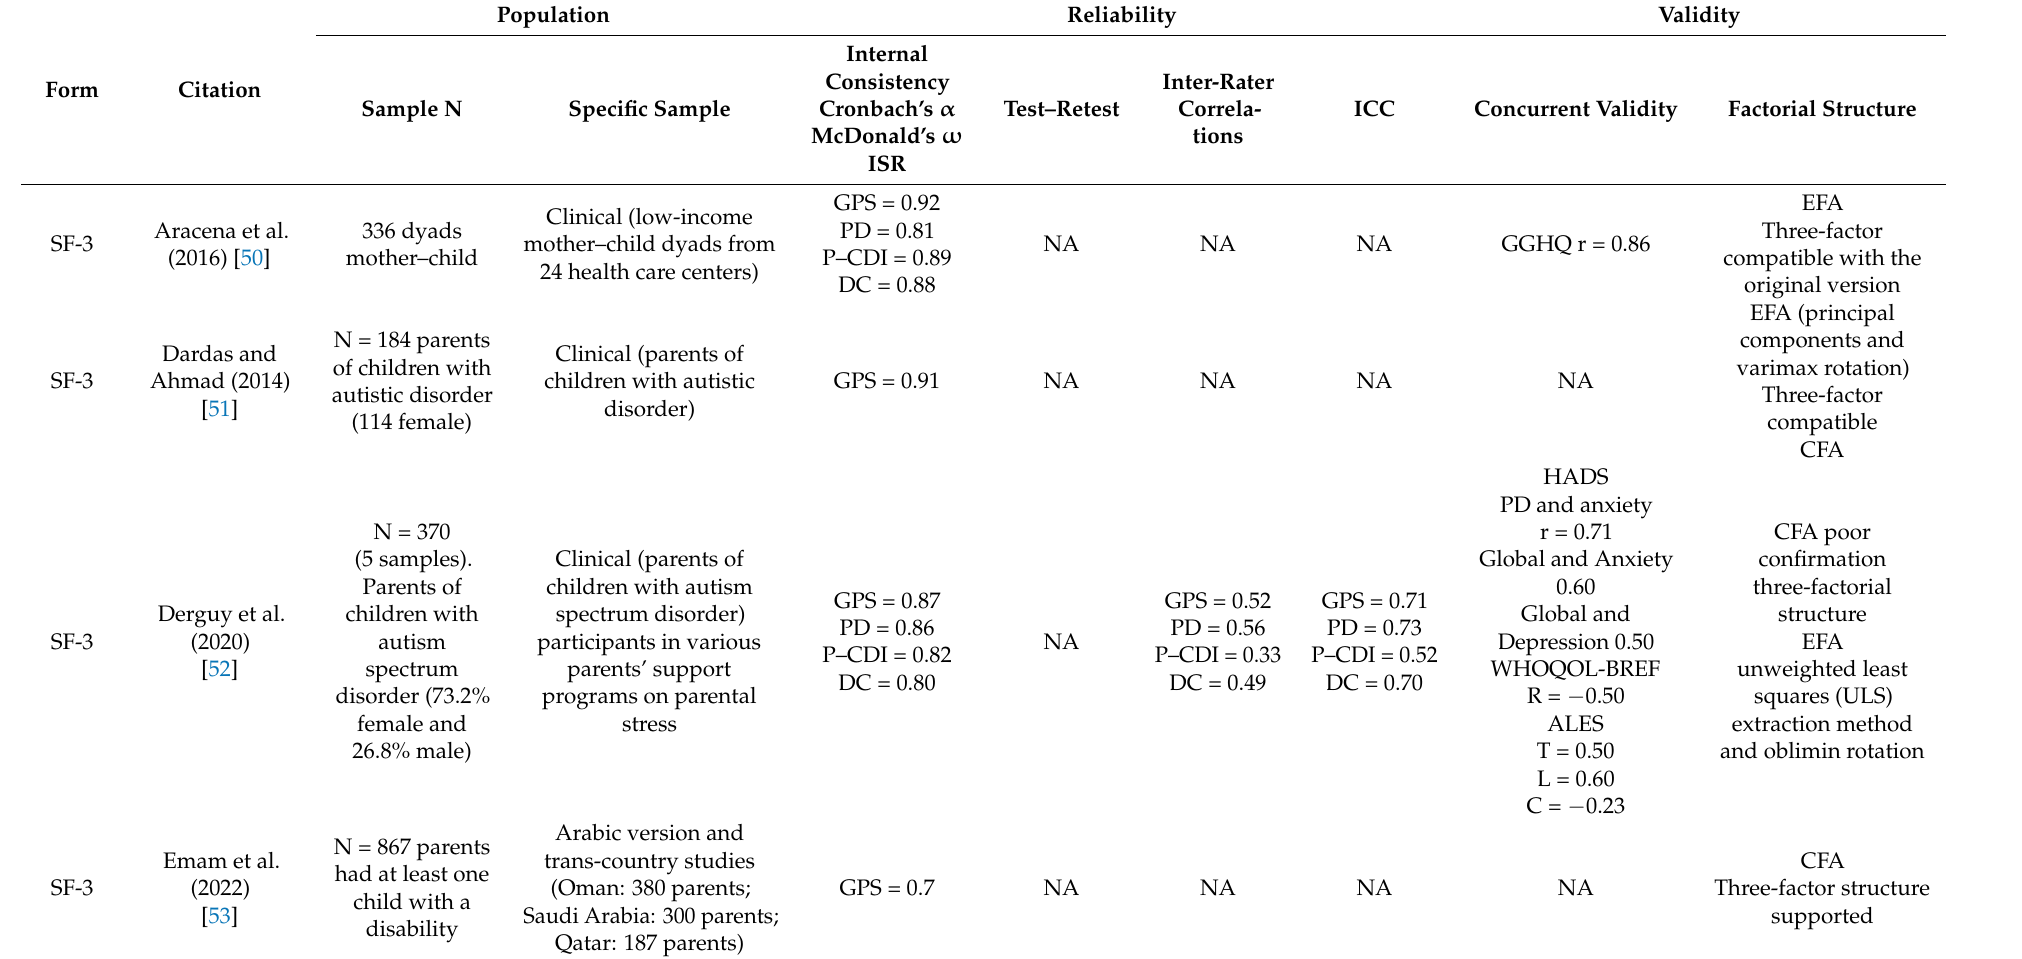
Table 1. Summary information about Parenting Stress Index